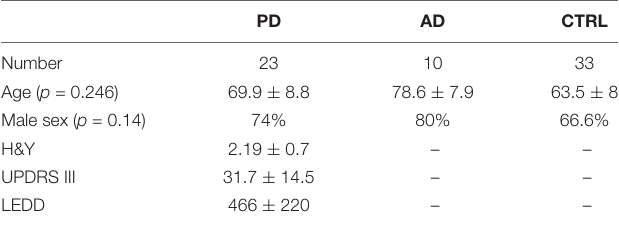
TABLE 1 | Number, age, male sex percentages, Hoehn and Yahr (H&Y), Unified Parkinson’s Disease Rating Scale motor part III (UPDRS III), levodopa